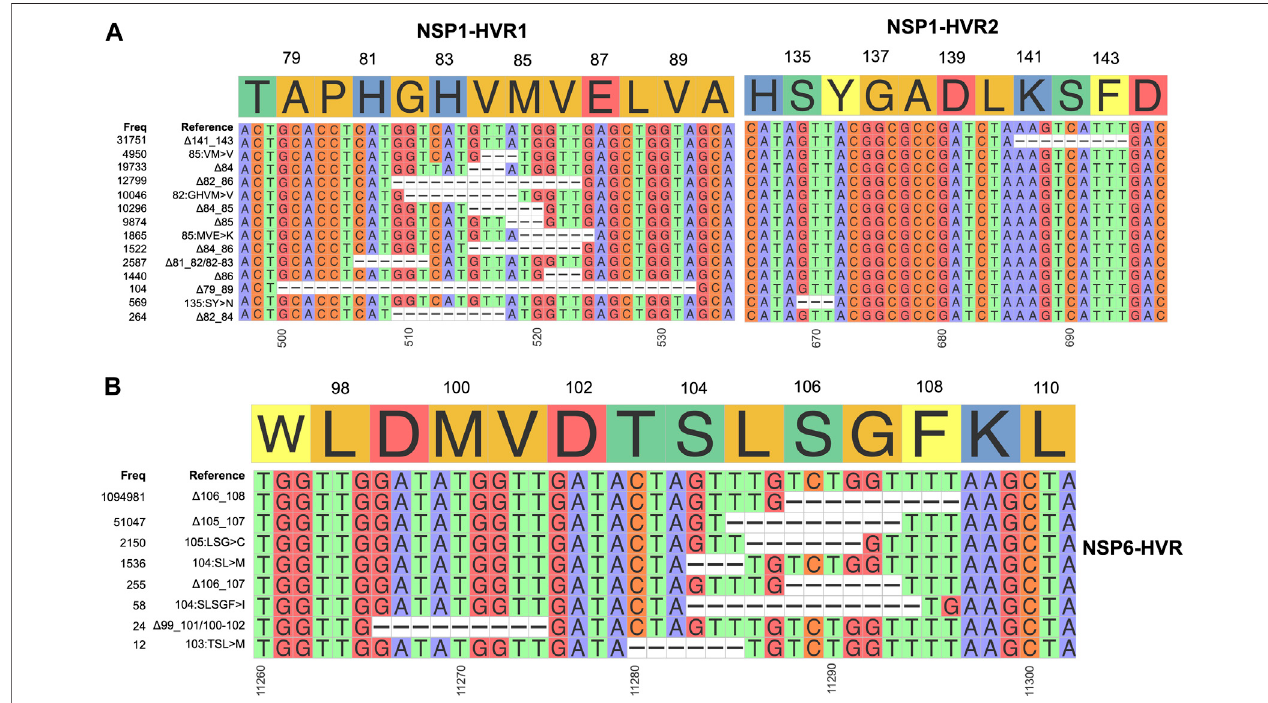
FIGURE5| Hypervariableregions(HVRs)ofNSP1andNSP6 (A) and (B) representcoordinatesofHVRsofNSP1andNSP6,respectively.Thenumberofgenomes containing a speci fi c indel is provided on the left side of each plot. Indels independently co-occur in several SARS-CoV-2 lineages.